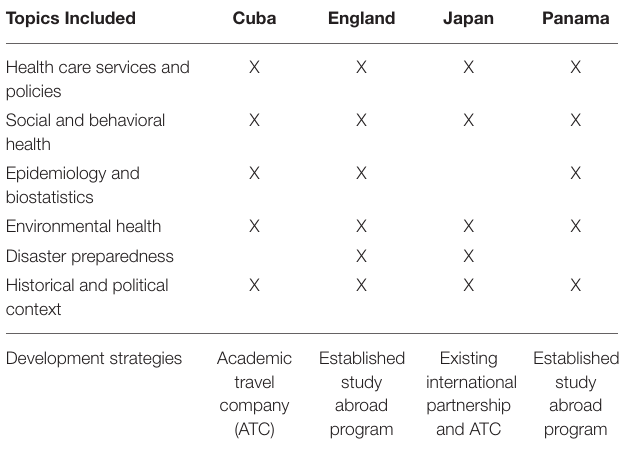
TABLE 1 | Study abroad courses: public health topics and development strategies.